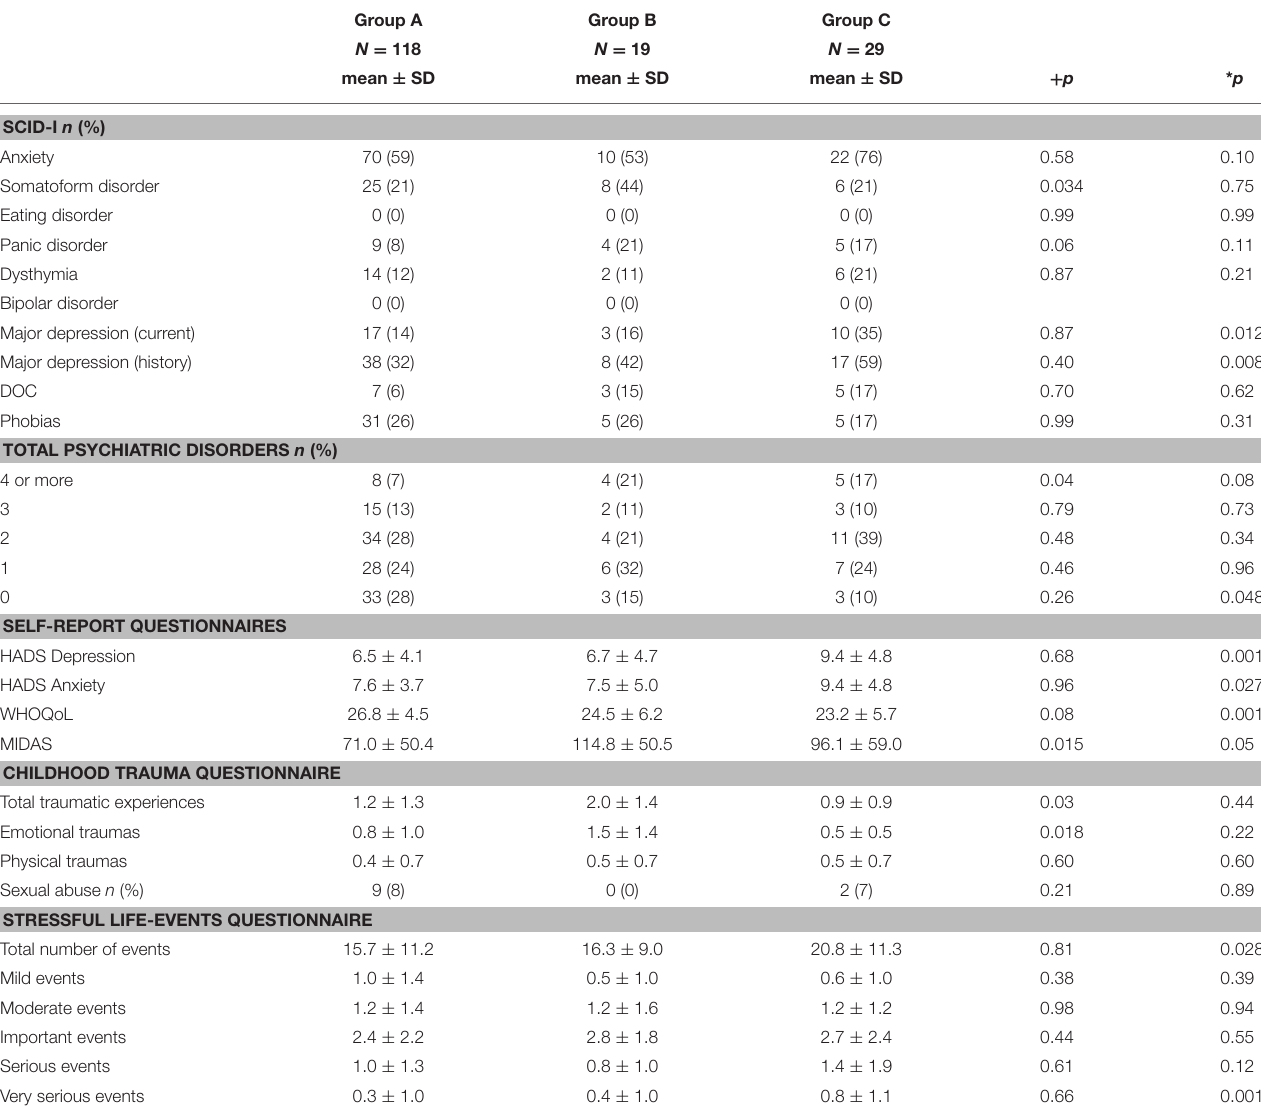
TABLE 2 | Psychological characteristics of the three